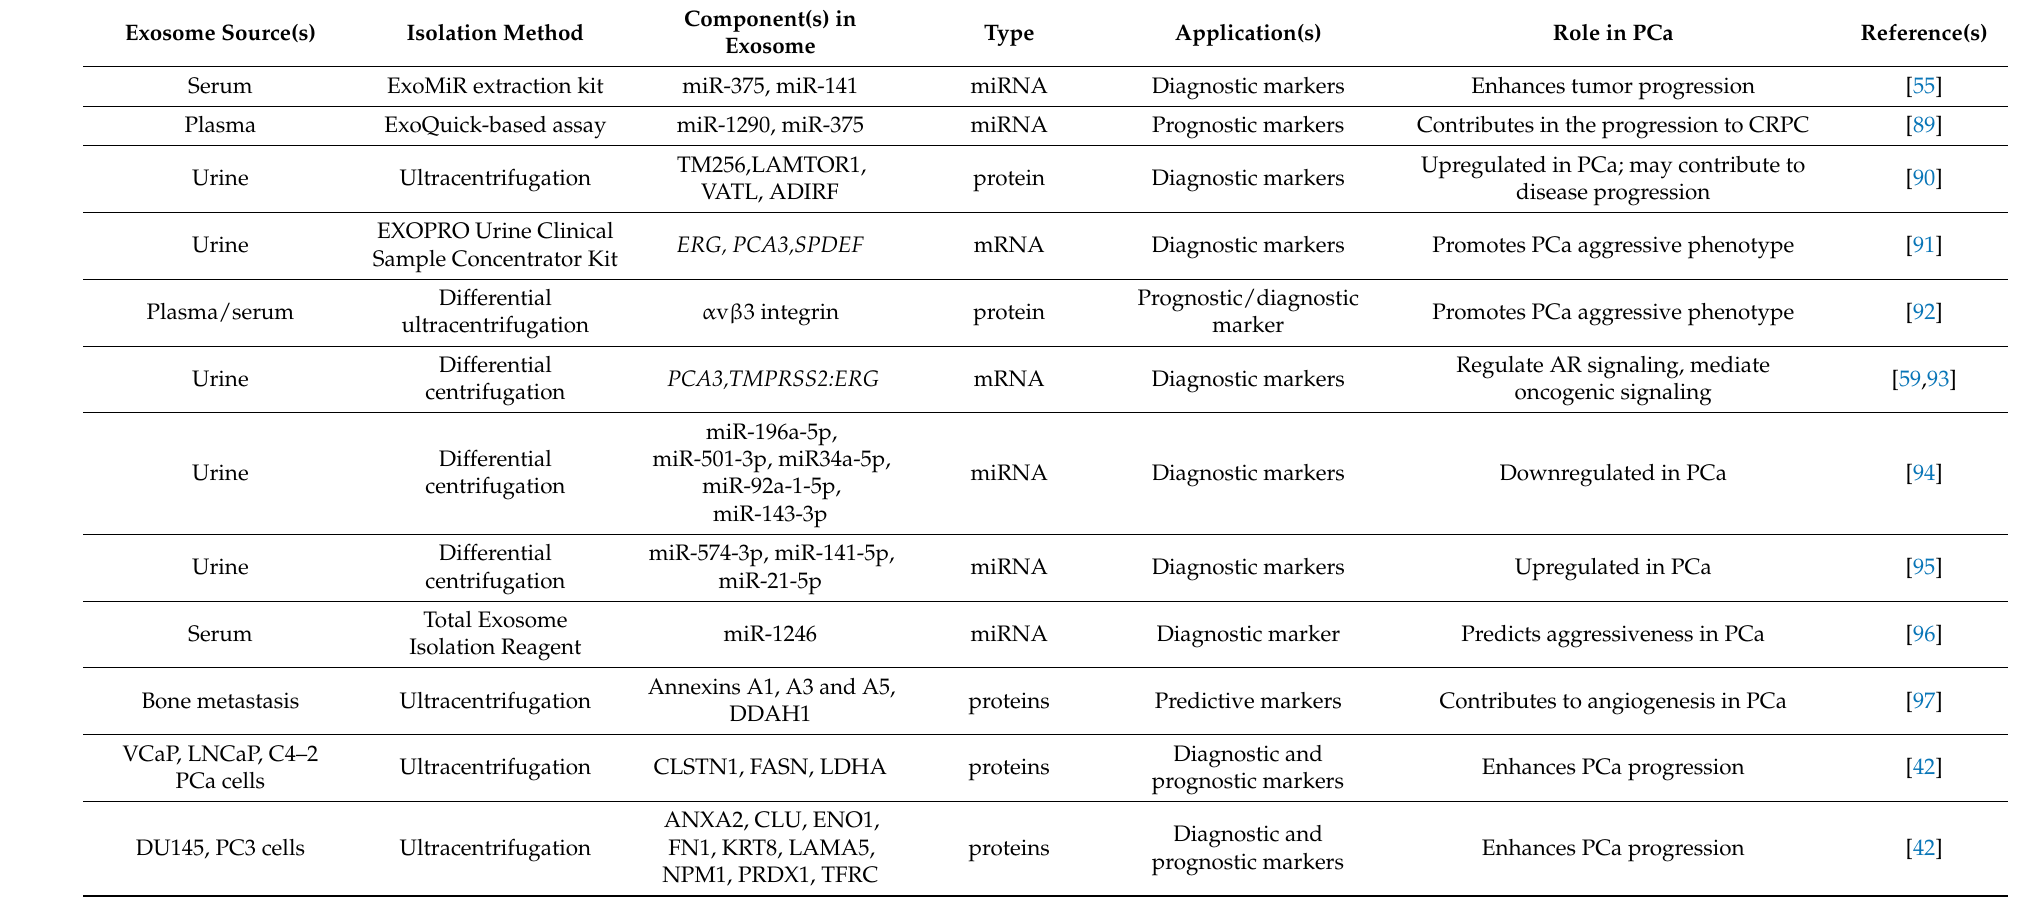
Table 1. Exosomal Markers in Prostate